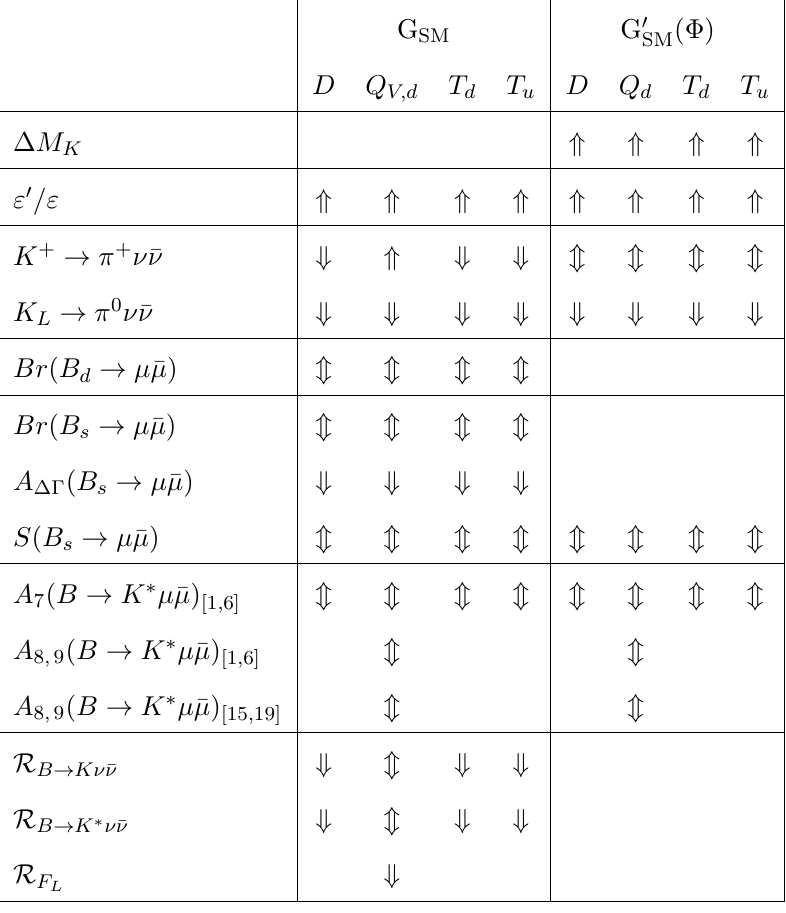
Table 11. Summary of allowed VLQ e(cid:11)ects in G SM - and G 0 ((cid:8))-models in (cid:13)avour observables SM after the (cid:12)t using experimental measurements of table 8. Possible enhancement, suppression or both w.r.t. SM predictions are indicated by according , or . Empty space means that the given model * + m does not predict sizeable e(cid:11)ects in that observable. Note that ( " 0 =" ) NP has been restricted (6.1), a(cid:11)ecting other s d !